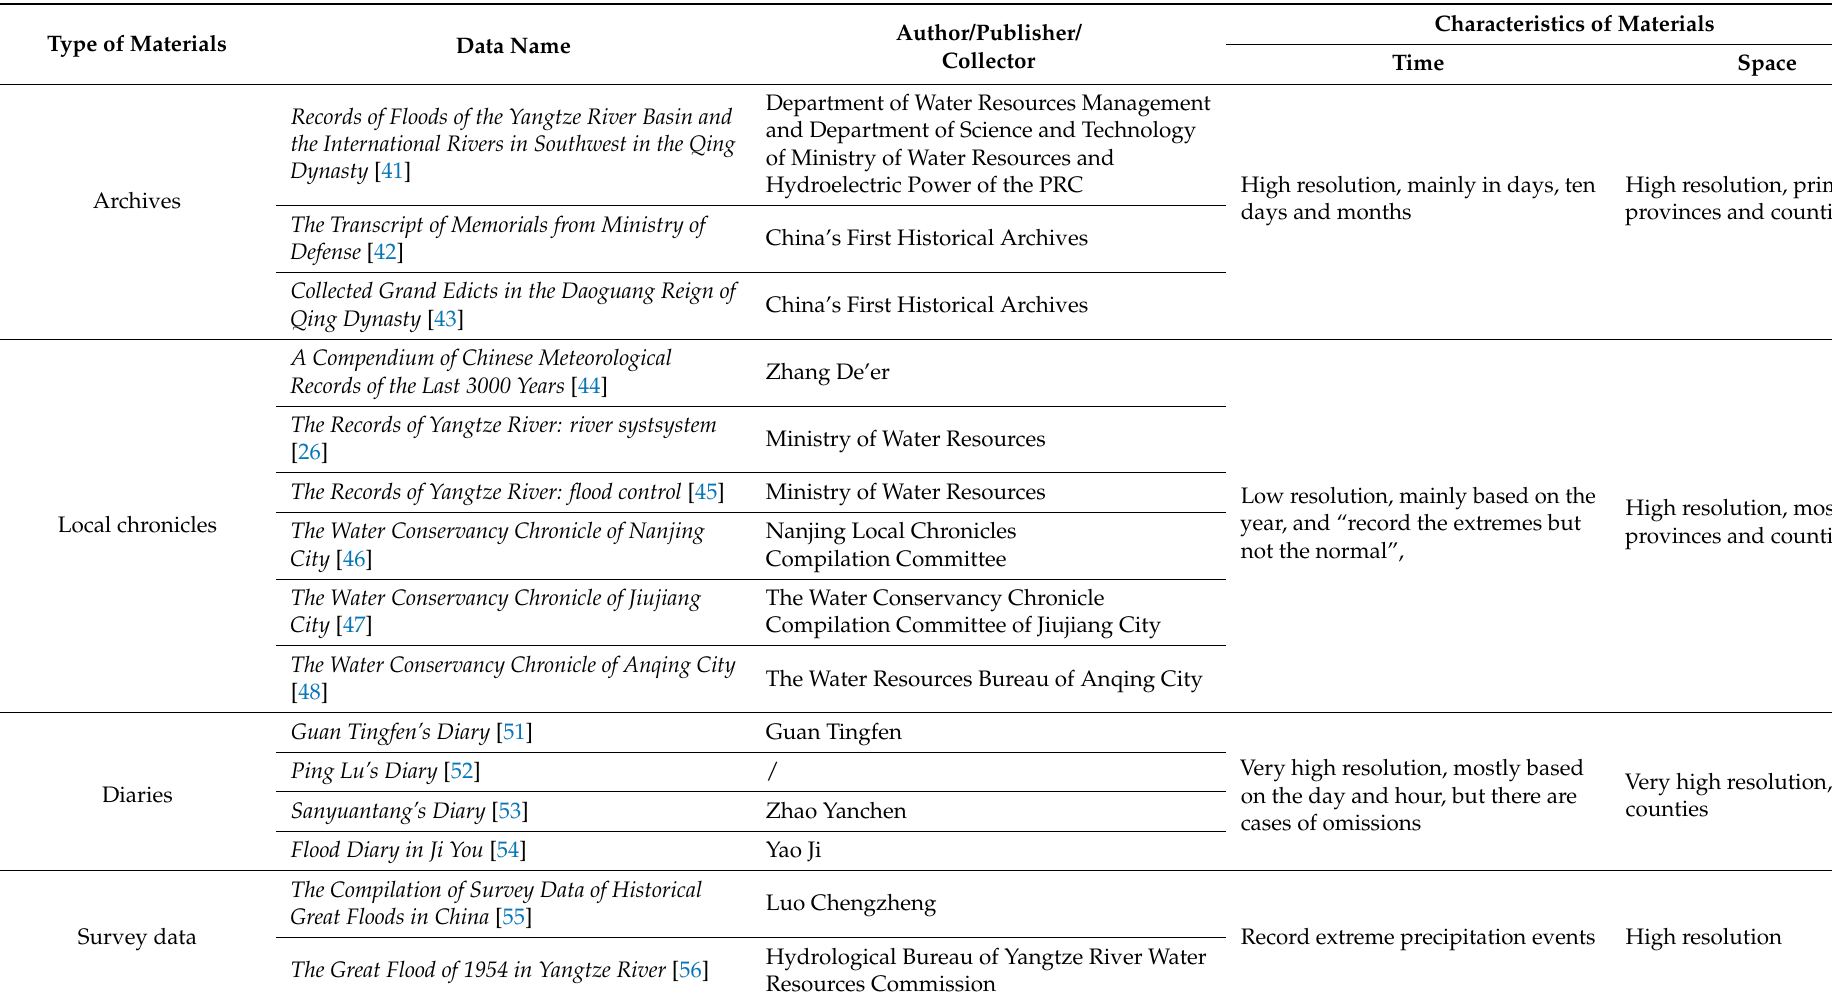
Table 1. Types and characteristics of materials utilized in this